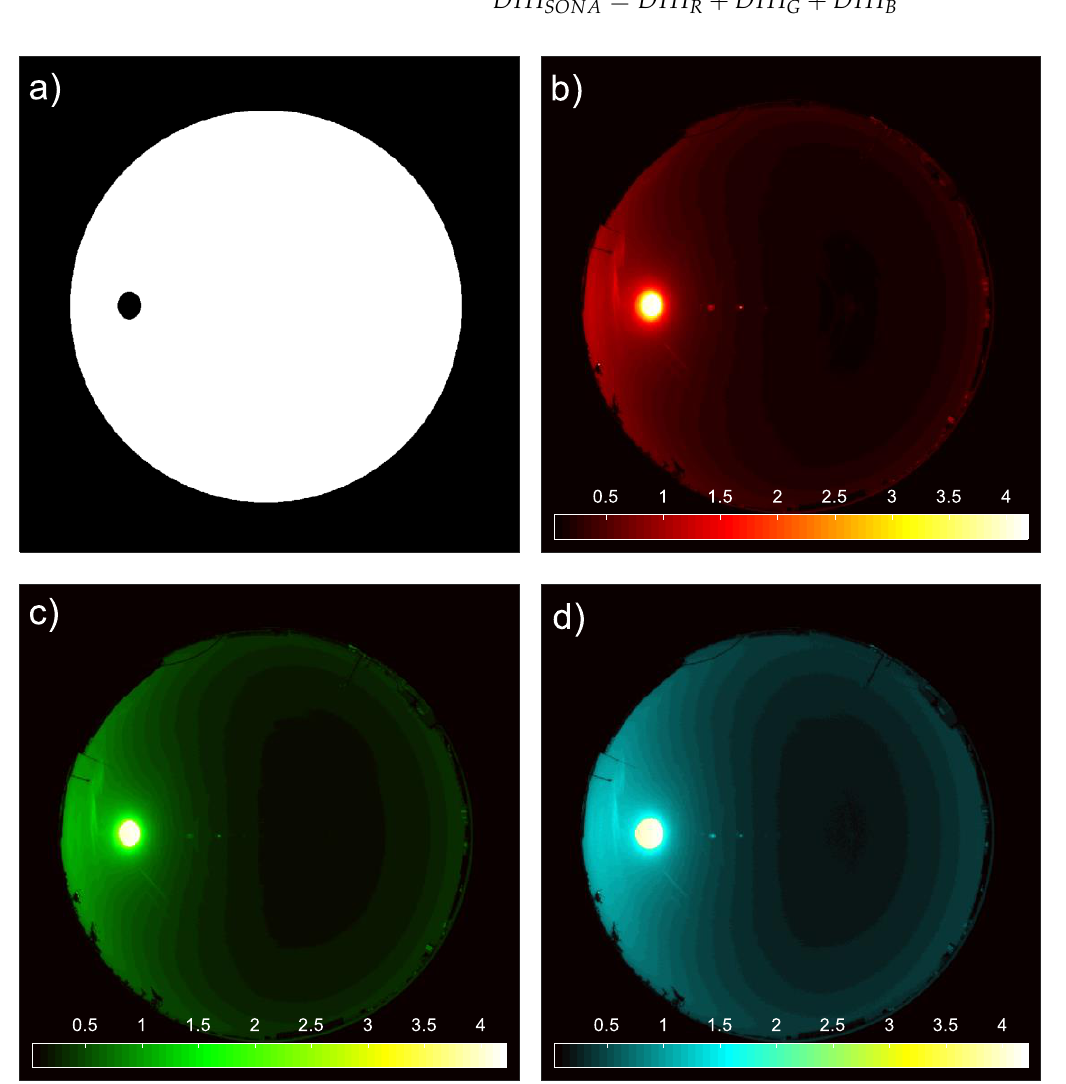
Figure 8. ( a ) Mask to obtain the DHI. ( b ) Red calibrated Irradiance in µW cm −2 . ( c ) Green calibrated Irradiance in µW cm −2 . ( d ) Blue calibrated irradiance in µW cm −2 . From a calibrated HDR sky-camera image on 27 June 2021 at 07:30 h under clear sky conditions.